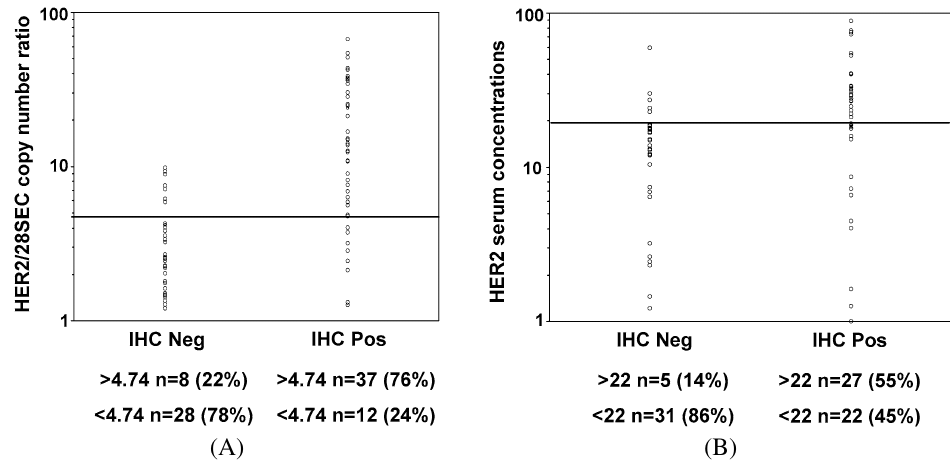
Fig. 2. (A) Scatter plot for HER2/28SEC copy number ratios for patients with positive (score 3 + ) and negative (scores 0 and 1 + ) IHC. The horizontal line indicates the optimal cut off for the HER2/28SEC copy number ratios (4.74), which gave a sensitivity of 76% and specificity of 91%. (B) Scatter plot for HER2 serum concentrations for patients with positive (score 3 + ) and negative (scores 0/1 + ) IHC. The horizontal line indicates the optimal cut off for the HER2 serum concentrations (22), which gave a sensitivity of 59% and specificity of 95%.